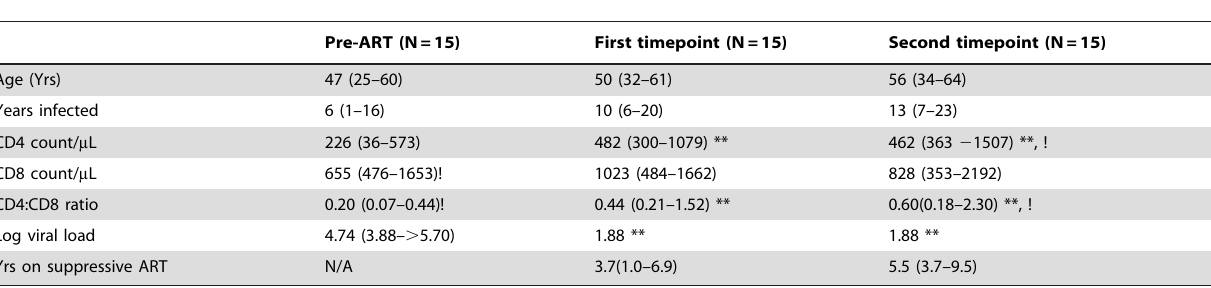
Table 3. Characteristics of ART-suppressed group over